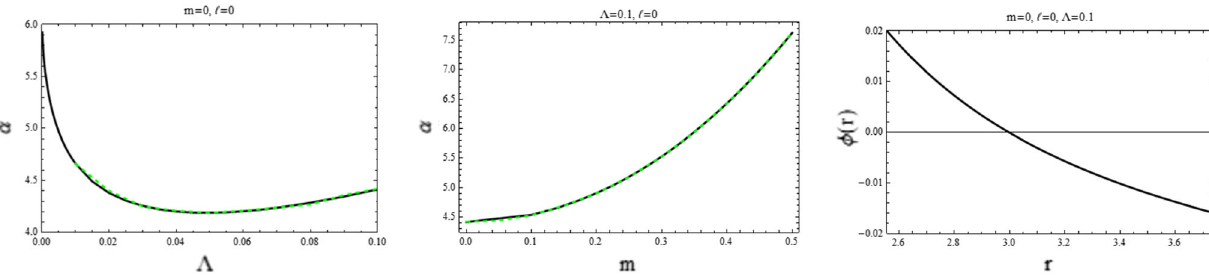
Fig. 14 The bifurcation points against (cid:2) (left panel) and scalar mass (middle panel) at which it could emerge a scalarized black hole from zero mode with k = 1. The right panel shows a typical profile of such scalar cloud. We have set M = 1